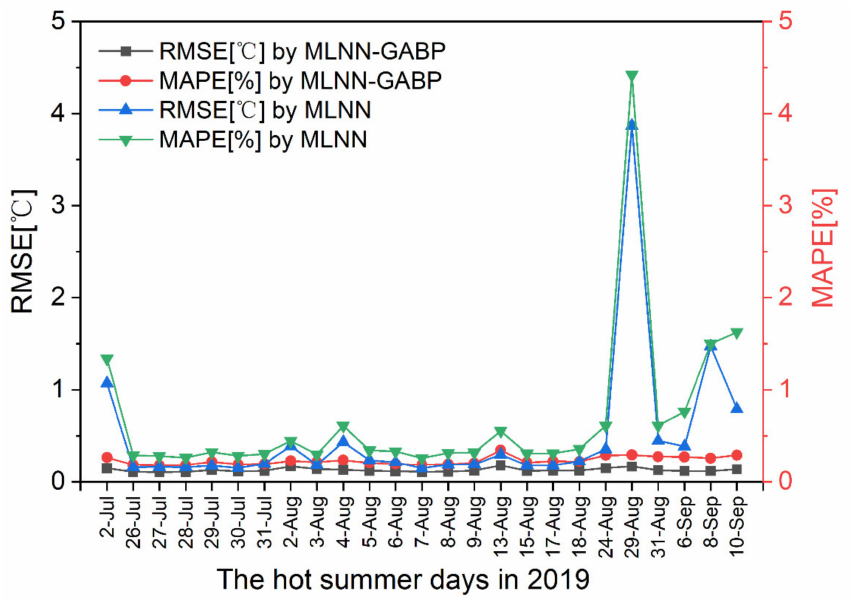
Figure 7. The RMSE and MAPE of the prediction results in each mesh on hot summer days in